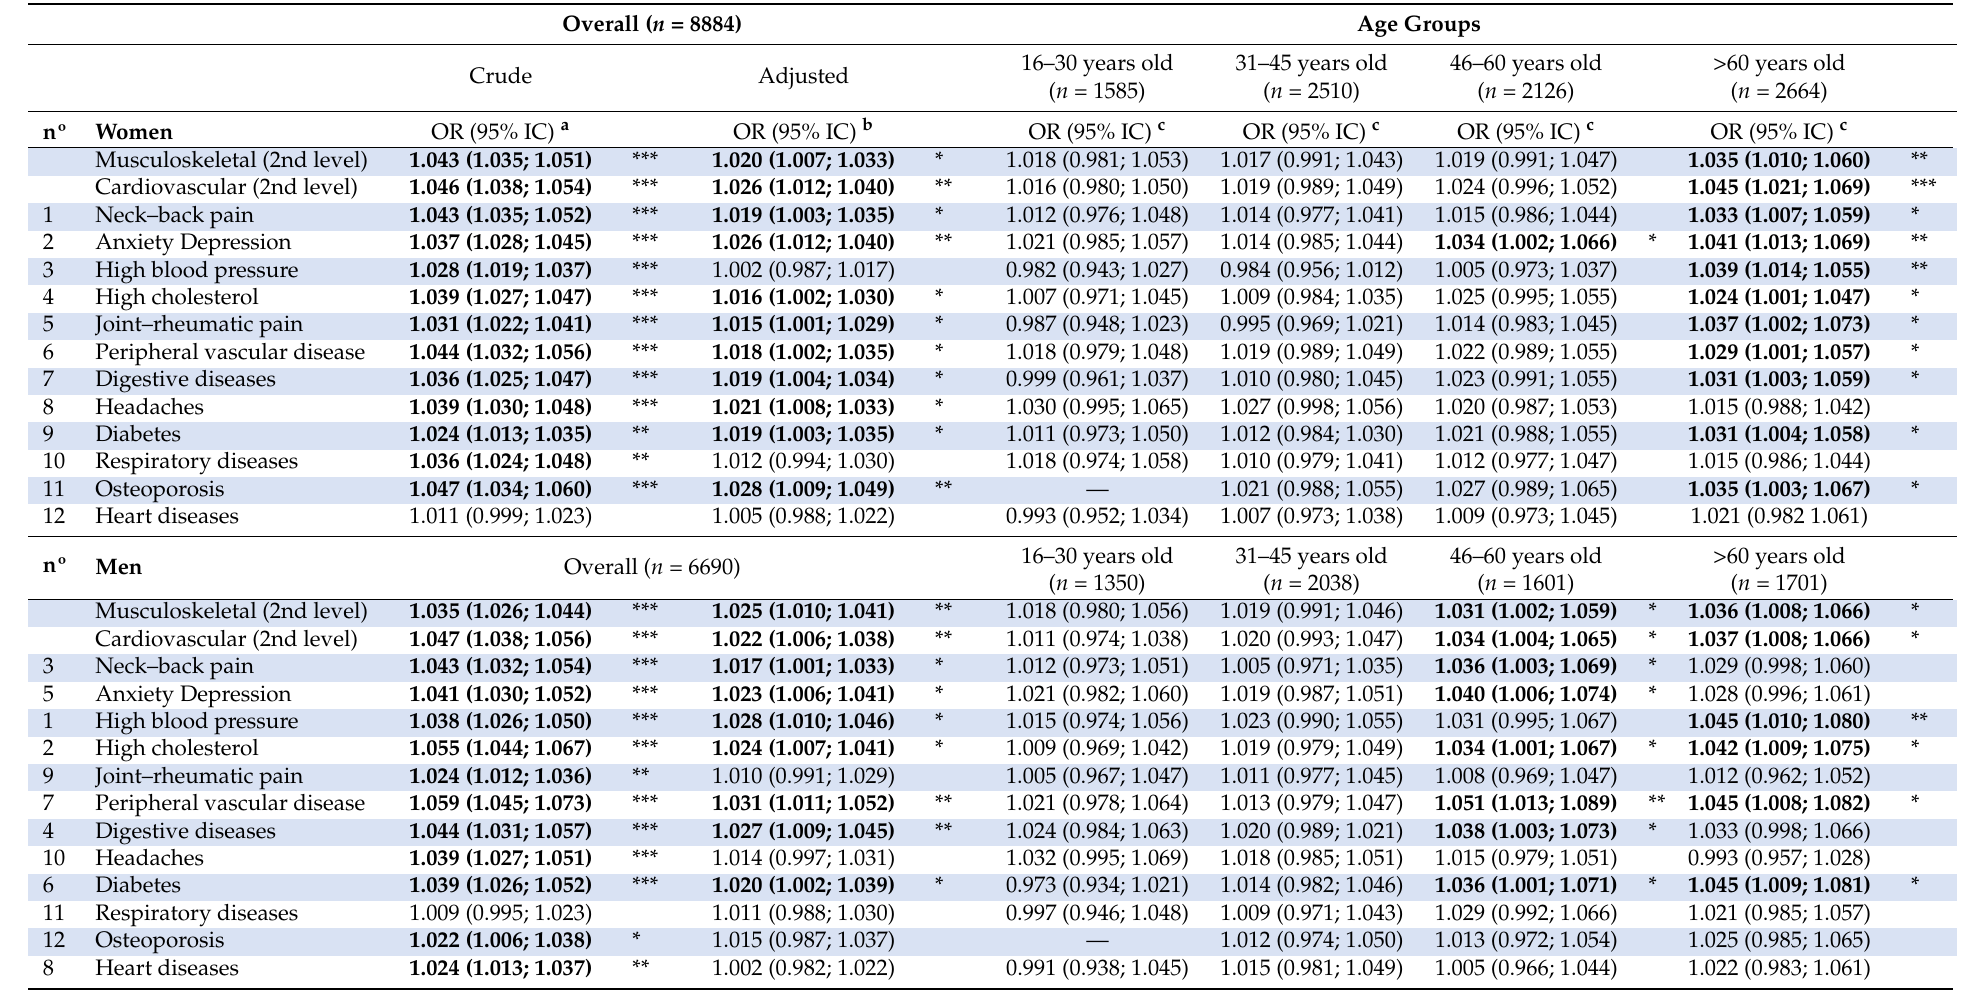
Table 3. Rate of change in 1997–2015 of the analyzed chronic morbidity for the overall sample and age